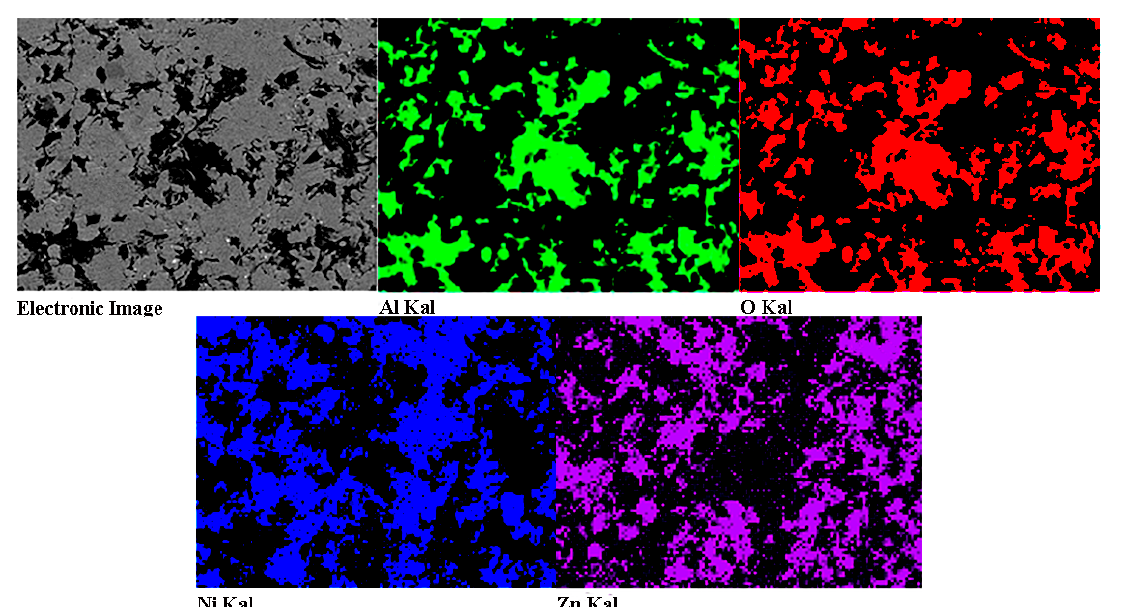
Figure 3. EDS mapping analysisof the polished top surface of (80 wt % Zn–20 wt % Ni)-30 vol % Al 2 O 3 composite coatings.